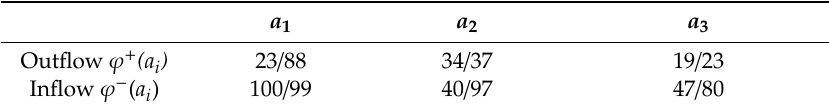
Table 5. Inflow and outflow for each